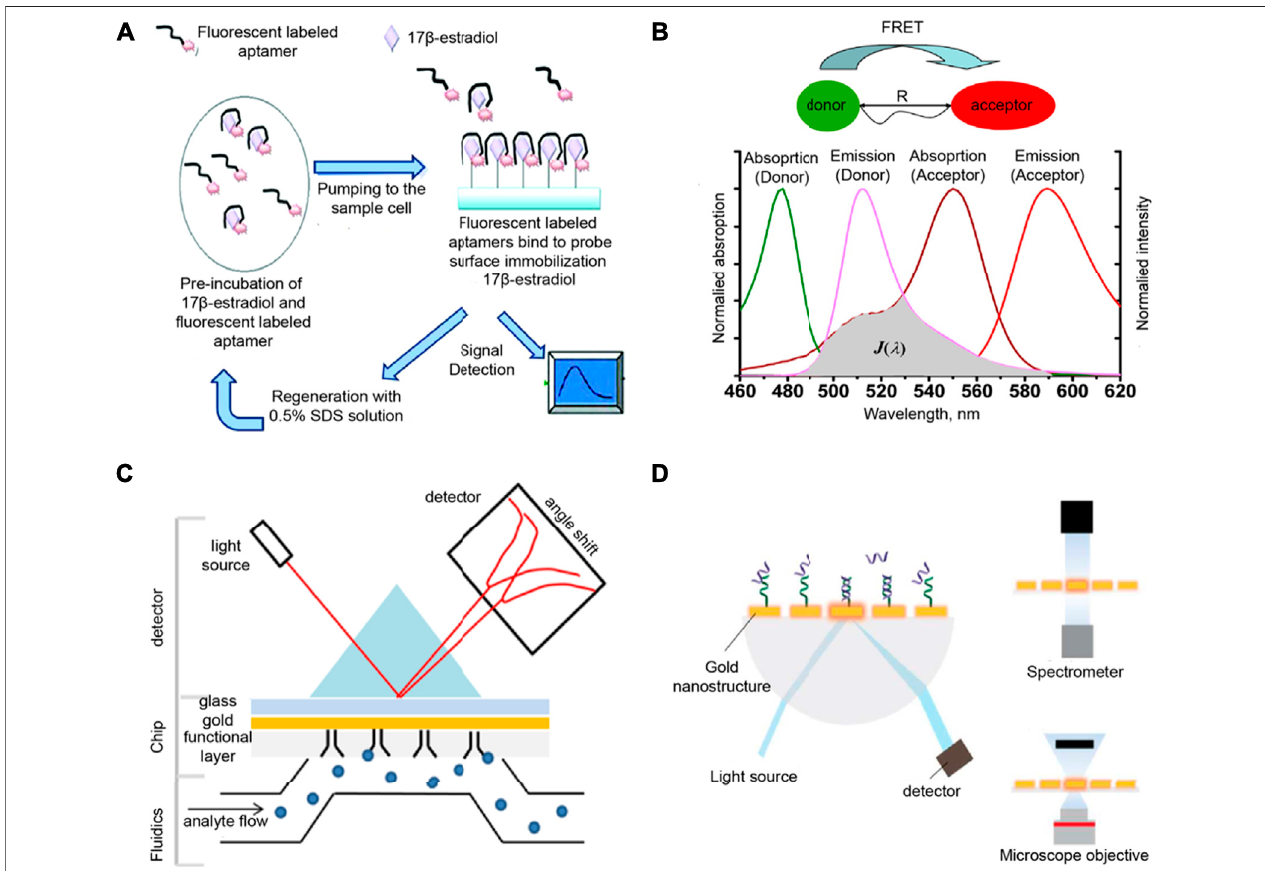
FIGURE 4 | (A) Fluorescent labeling-based, (B) FRET-based, (C) SPR-based, and (D) LSPR-based mechanisms for optical biosensors. Adapted from (Yildirim et al., 2012; Yuan et al., 2013; Damborsky et al., 2016; Huertas et al., 2019). Copyright 2012, 2013 American Chemical Society; 2016 Portland Press.